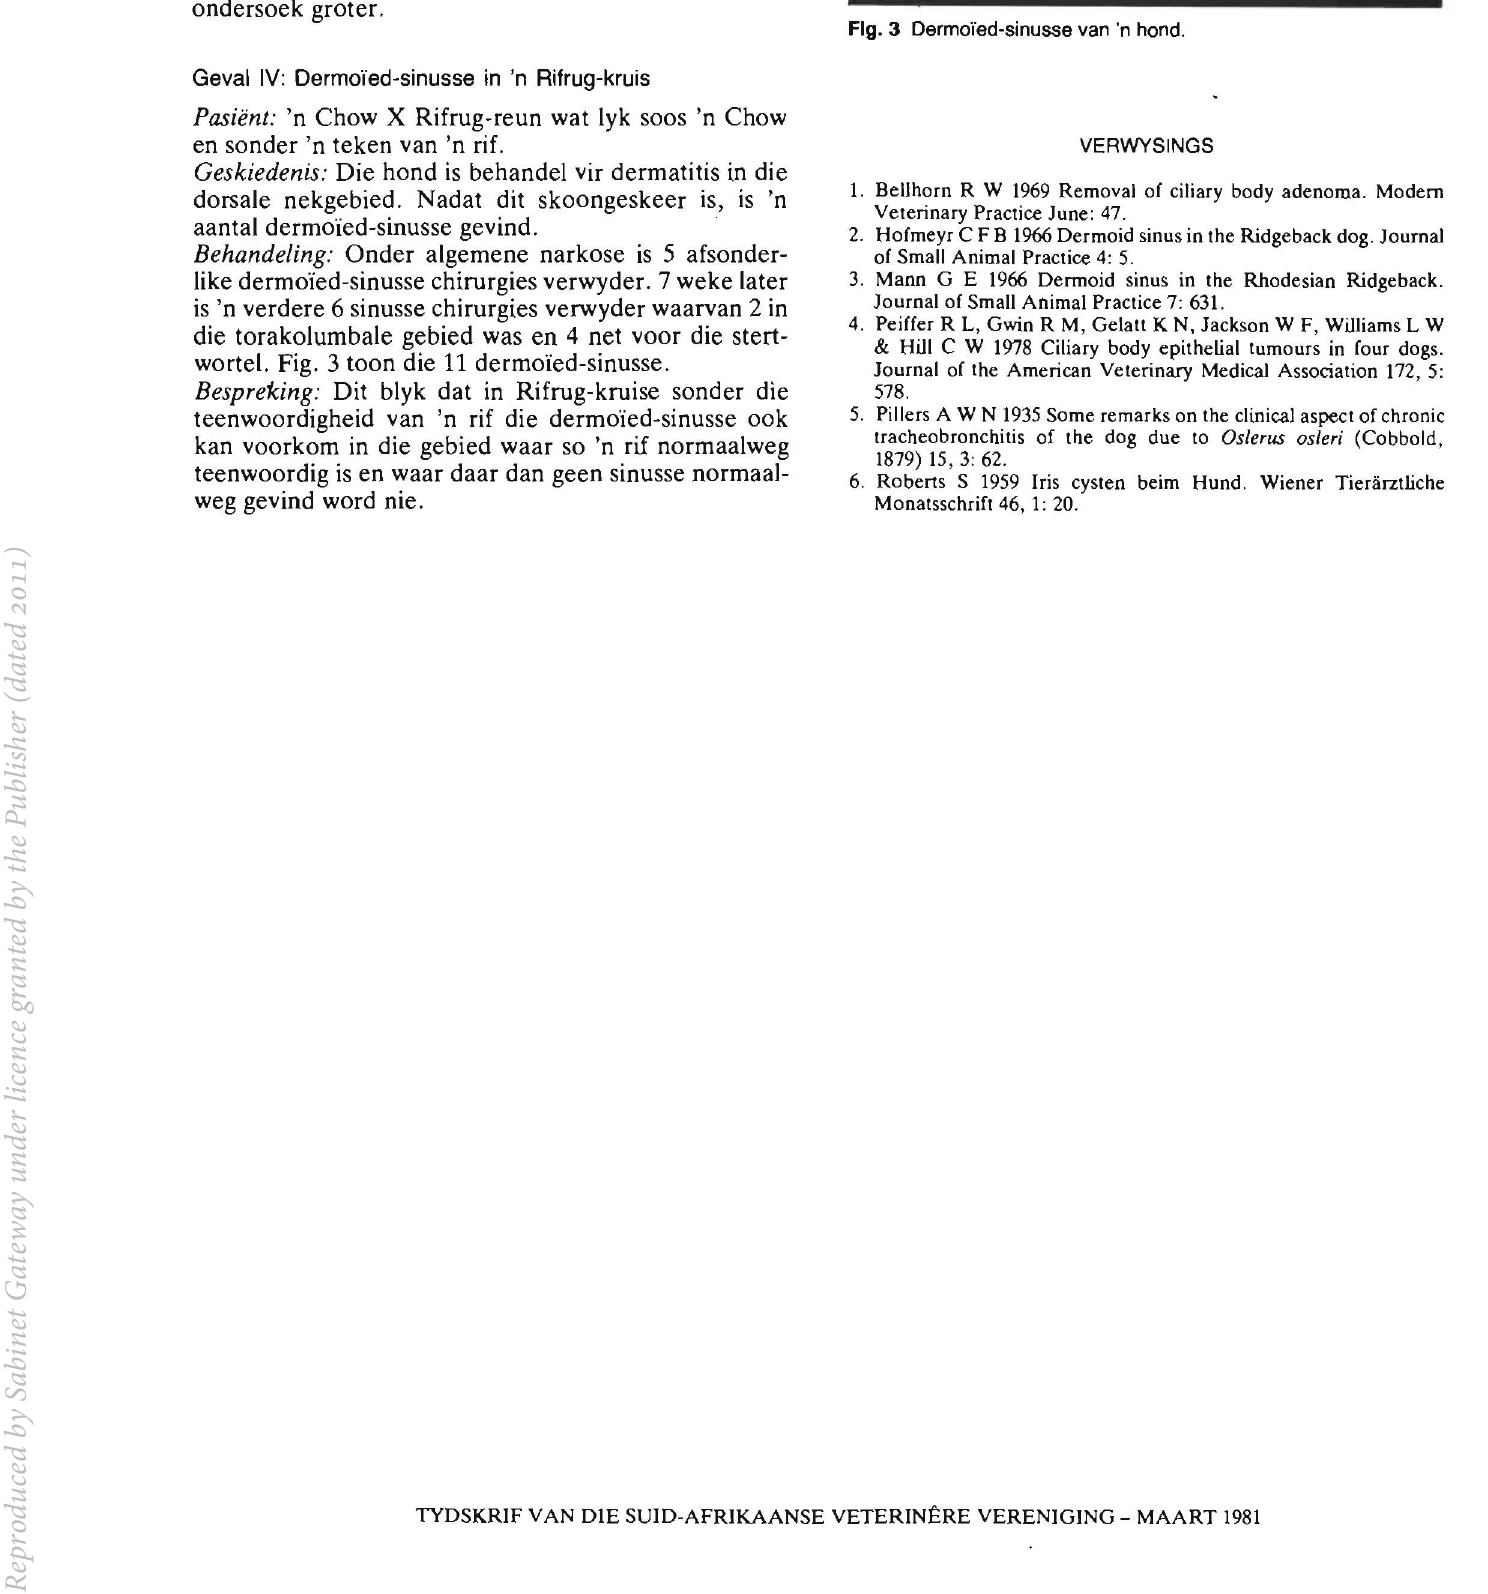
Fig. 3 Dermoi'ed-sinusse van 'n hand.